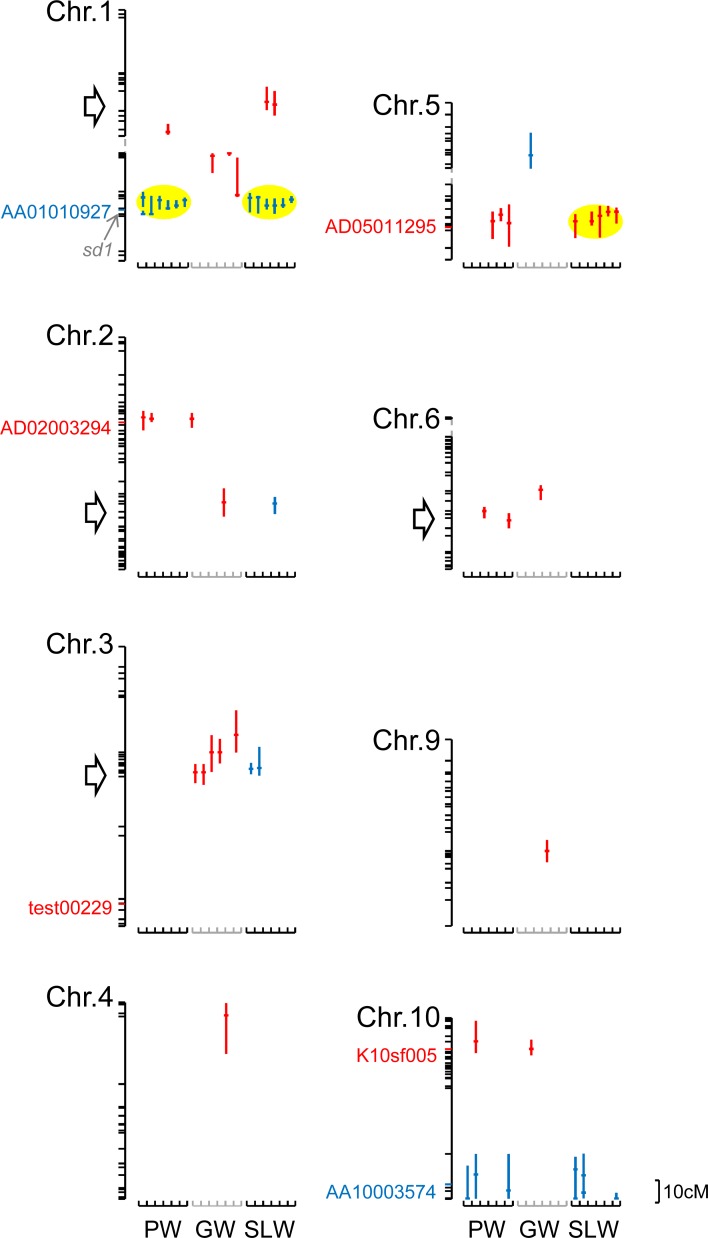
Locations of detected QTLs.Vertical bars to the right of the linkage maps denote 1-LOD confidence intervals, and horizontal bars denote the position of the LOD peak at each QTL. Color indicates whether ‘Tachisugata’ (blue) or ‘Hokuriku 193’ (red) alleles had a positive effect. The single nucleotide polymorphism (SNP) markers that were selected to increase biomass yield in our previous study are similarly colored. Yellow ellipses indicate stable or nearly stable QTLs; arrows indicate significant QTL regions detected in the previous study along with the six selected QTLs. Broken lines indicate linkage gaps. PW, plant weight; GW, grain weight; SLW, stem and leaf weight.